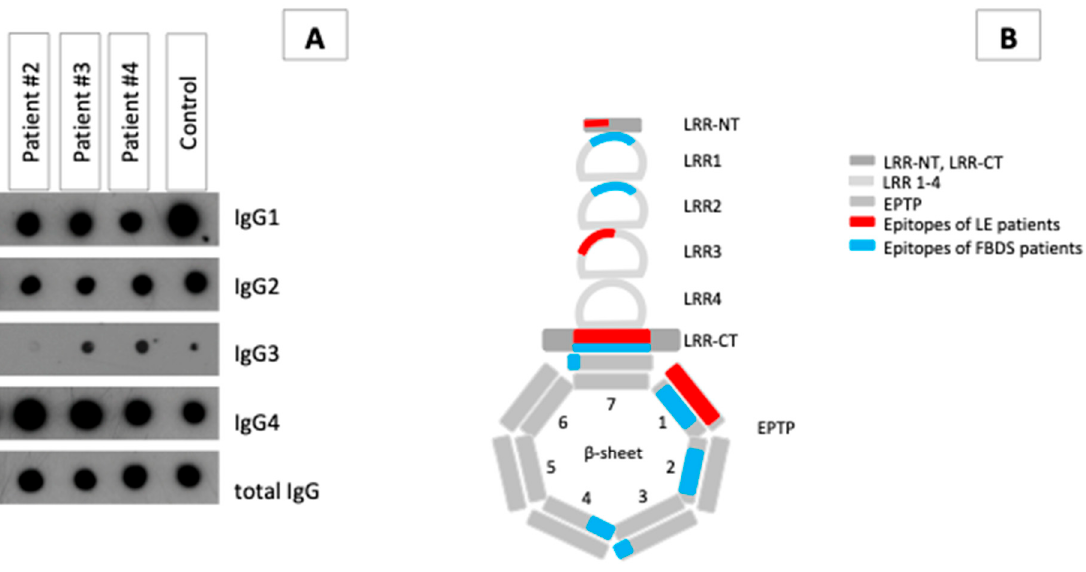
Figure 1. Ab properties on four anti-LGI1 ab-associated AE patients. ( A ) Dot blot analysis splitting up the LGI1-specific IgG fraction of the four patients into IgG subclasses. ( B ) Schematic presenta- tion of the data of the epitope mapping, which show the binding of the anti-LGI1 abs of the re- spective patients to the LGI1 molecule according to a tertiary structure model of Yamagata and coworker [7]. Blue colors represent epitopes of FBDS patients, and red represent epitopes of LE patients.